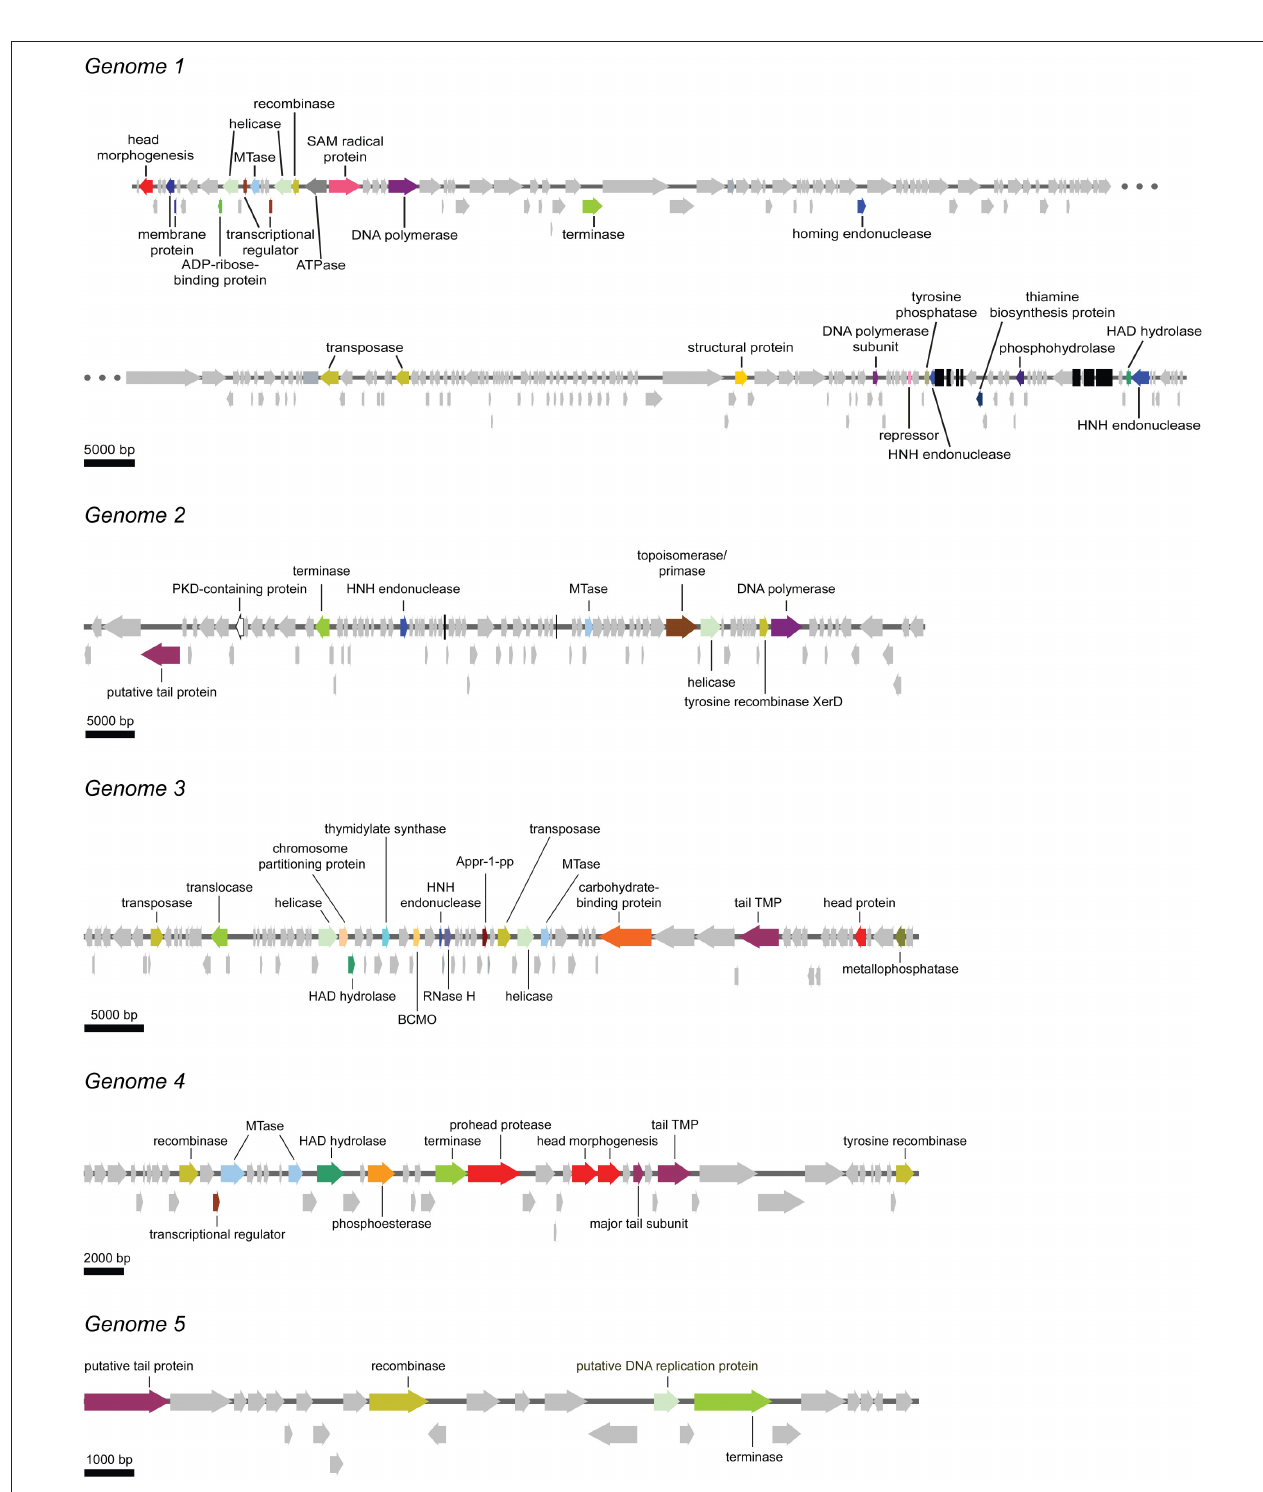
FIGURE 5 | Schematic overview of the five putative complete viral genomes retrieved from the viral metagenome of the bacteriophage population in the Methylomirabilis bioreactor enrichment culture. Arrows with the same color represent genes encoding for the same putative functional category. Light gray arrows indicate hypothetical proteins. Black bars in genome 1 and genome 2 represent tRNAs. Appr-1-pp, ADP-ribose 1-phosphate phosphatase; BCMO, β -carotene 15, 15 ′ -monooxygenase; HAD hydrolase, haloacid dehalogenase; MTase, methyltransferase; PKD-containing protein, polycystic kidney disease-containing protein; RNase H, ribonuclease H; tail TMP, tail tape measure protein.